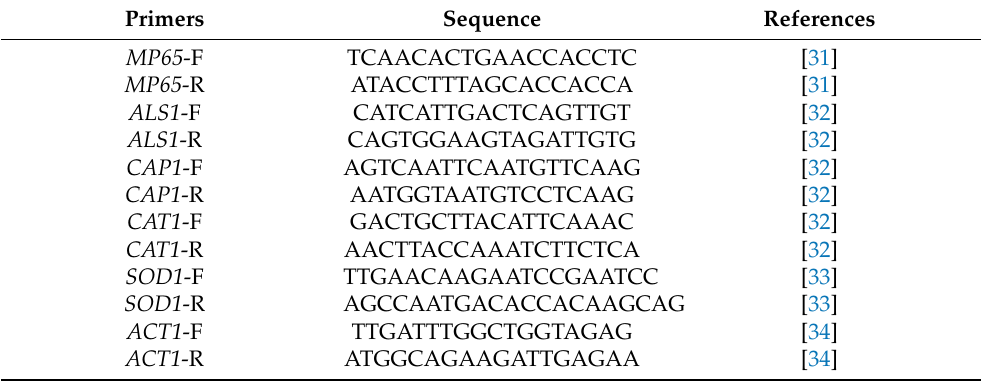
Table 1. Gene-specific primers used for the relative quantification of gene expression by